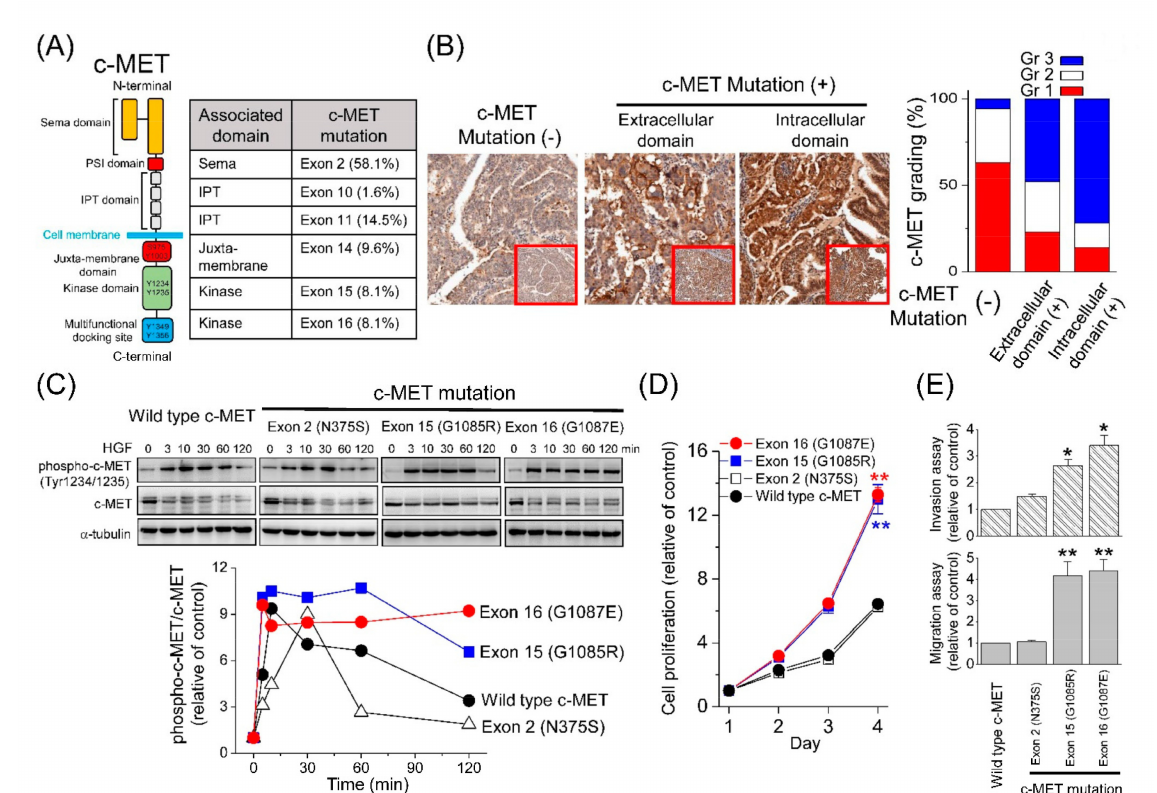
Figure 2. Differential effects of various MET mutations on c-MET phosphorylation and cellular functions. ( A ) The structure of c-MET (left) and distribution of MET mutations (right). Sema, semaphoring domain; PSI, plexin–semaphorin–integrin domain; IPT, immunoglobulin–plexin–transcription domain. ( B ) Representative images and grading of c-MET expression in endometrial cancer. The expression of c-MET was scored as grade 1–3, according to the percentage of the positively-stained tumor cells and the intensity of the staining. ( C ) Time course of c-MET phosphorylation in response to HGF (50 ng/mL) stimulation. Cell lysates from various clones of the endometrial cancer RL95-2 cells were immunoblotted with anti-c-MET, anti-phospho-c-MET, and anti- α -tubulin antibodies (upper). The expression levels were quantified, and the ratios of phosphor-c-MET to total c-MET are shown (bottom). ( D ) Cell proliferation, invasion, and migration. ( E ) Assays using various clones of the RL95-2 cells. Each value represents the mean ± standard error of mean (SEM) from at least three experiments. *, p < 0.05; **, p <